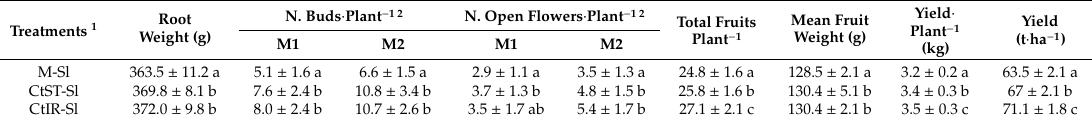
1. Labels related to di ff erent treatments are described in Table 2. 2. Number of buds and open flowers per plant were recorded at 12 (M1) and 13 (M2) weeks post-sowing. Data (means ± standard deviations) related to root weight (g) ( n = 24 plants), yield per plant (kg), and yield (t · ha − 1 ) ( n = 48 plants) were analyzed by one-way ANOVA with LSD post-hoc test. The rest of parameters ( n = 48 plants) were analyzed by Kruskal–Wallis test with Nemenyi post-hoc Agronomy 2020 , 10 , x FOR PEER REVIEW test. Di ff erent letters within each column indicate significant di ff erences among treatments ( p < 0.05).